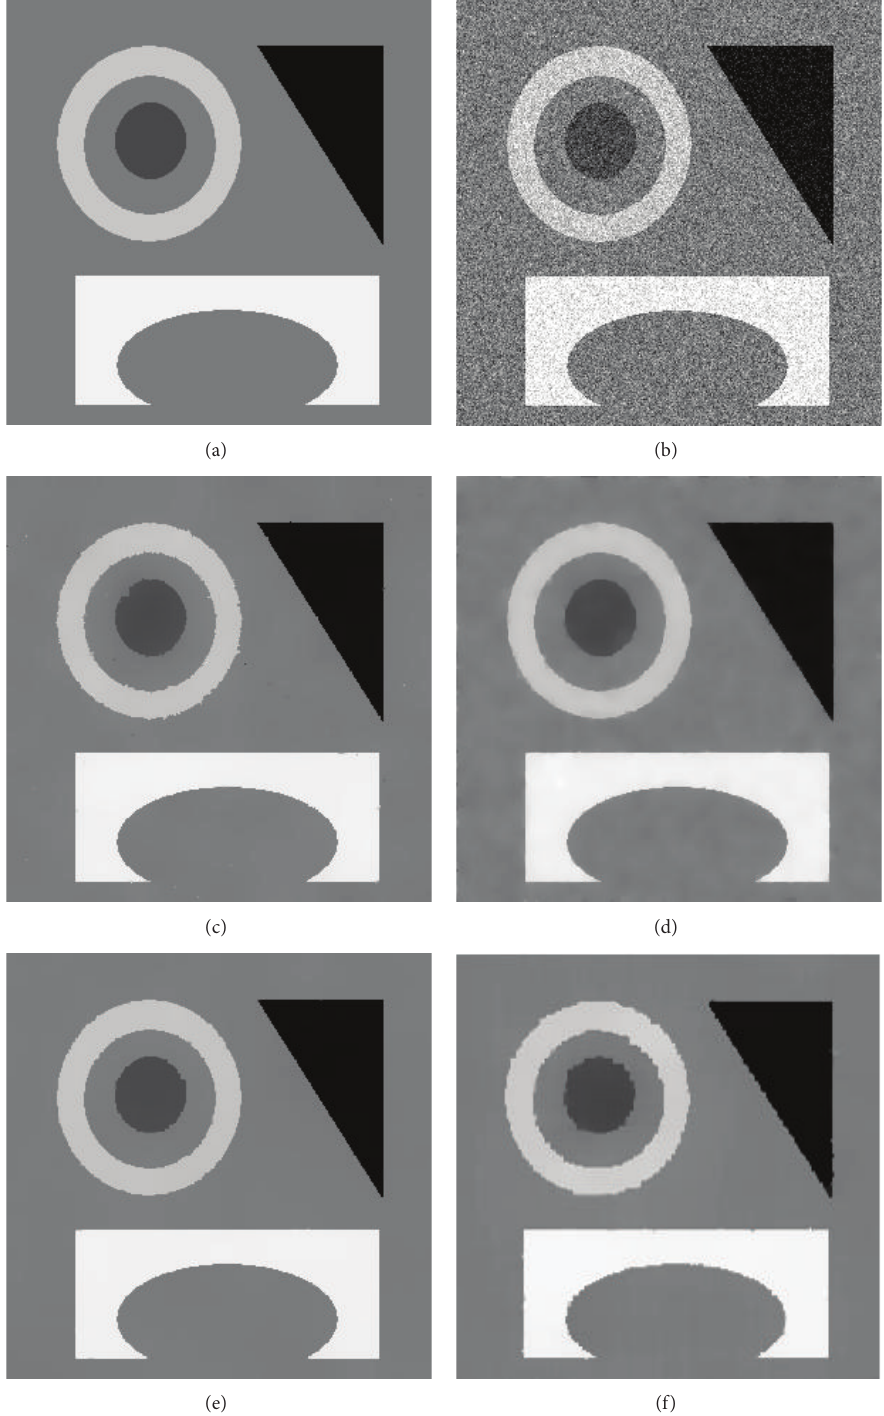
Figure 1: Synthetic image ( 300 × 300 ). (a) Original image. (b) Noisy image corrupted by Gaussian noise for 𝜎 = 30 . (c) PM algorithm, 𝐾 = 4 , 𝜏 = 0.25 (356 steps). (d) TV algorithm, 𝜏 = 0.25 (205 steps). (e) Our method, 𝐾 = 0.01 , 𝜏 = 5 (65 steps). (f) D- 𝛼 -PM algorithm, 𝑘 = 1 , 𝜏 = 0.25 , (40